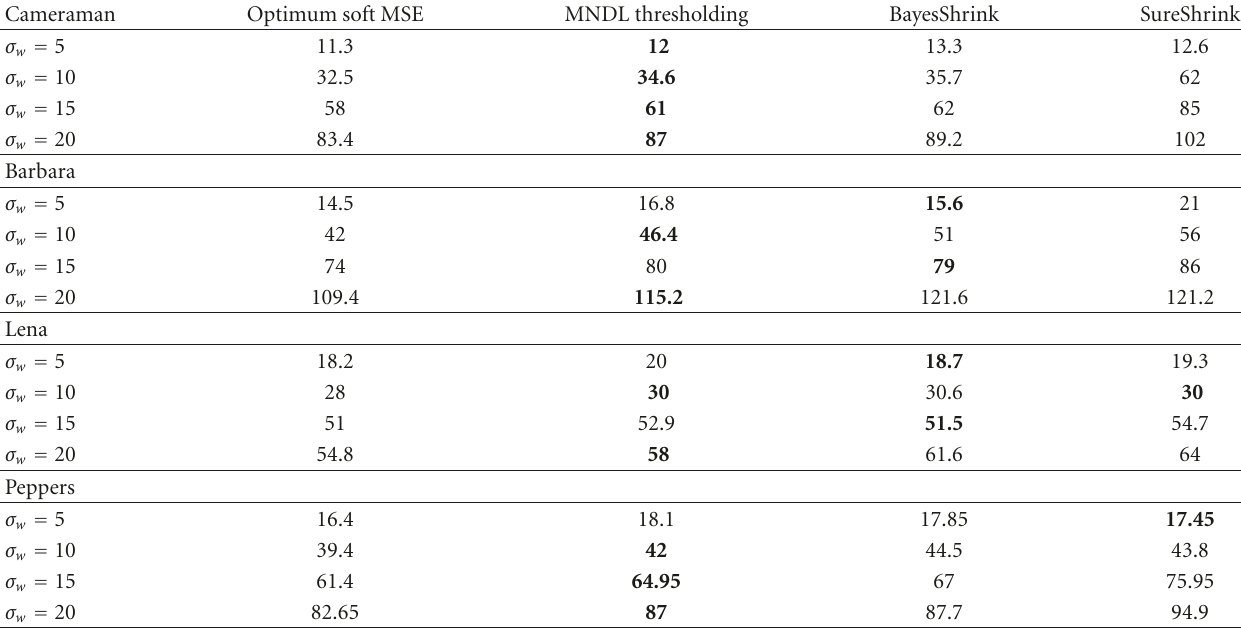
Table 4: MSE for various images with (1) Optimum soft MSE, (2) MNDL soft thresholding, (3) BayesShrink, and (4) SureShrink. Averaged over five runs.